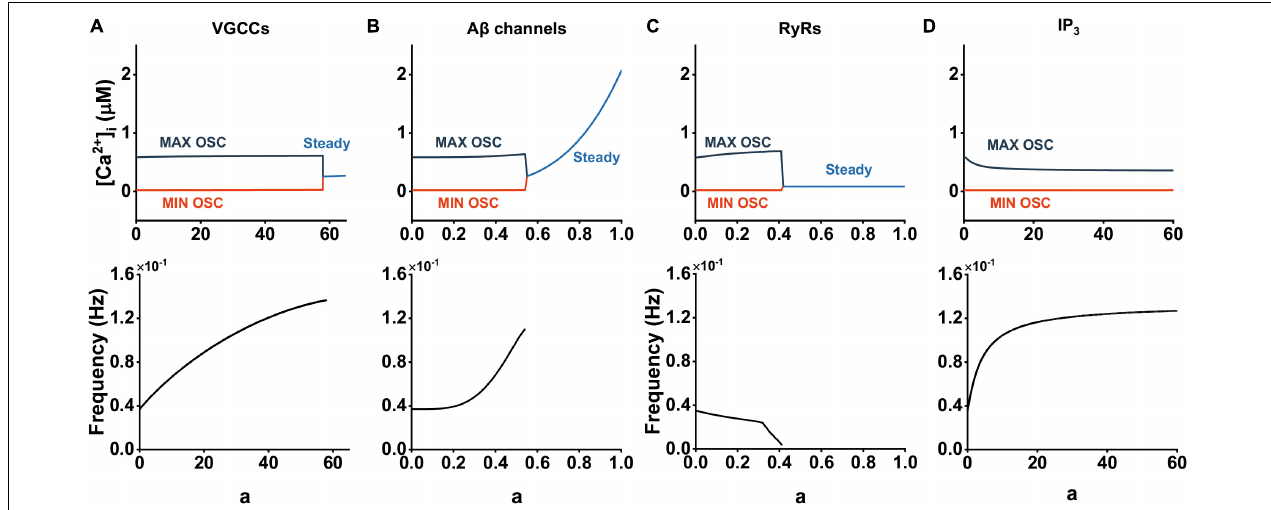
FIGURE 4 | Contribution of A β on cytosolic Ca 2 + dynamics through different pathways. (A–D) Bifurcation diagrams of [Ca 2 + ] i plotted against the A β level with affected pathways.